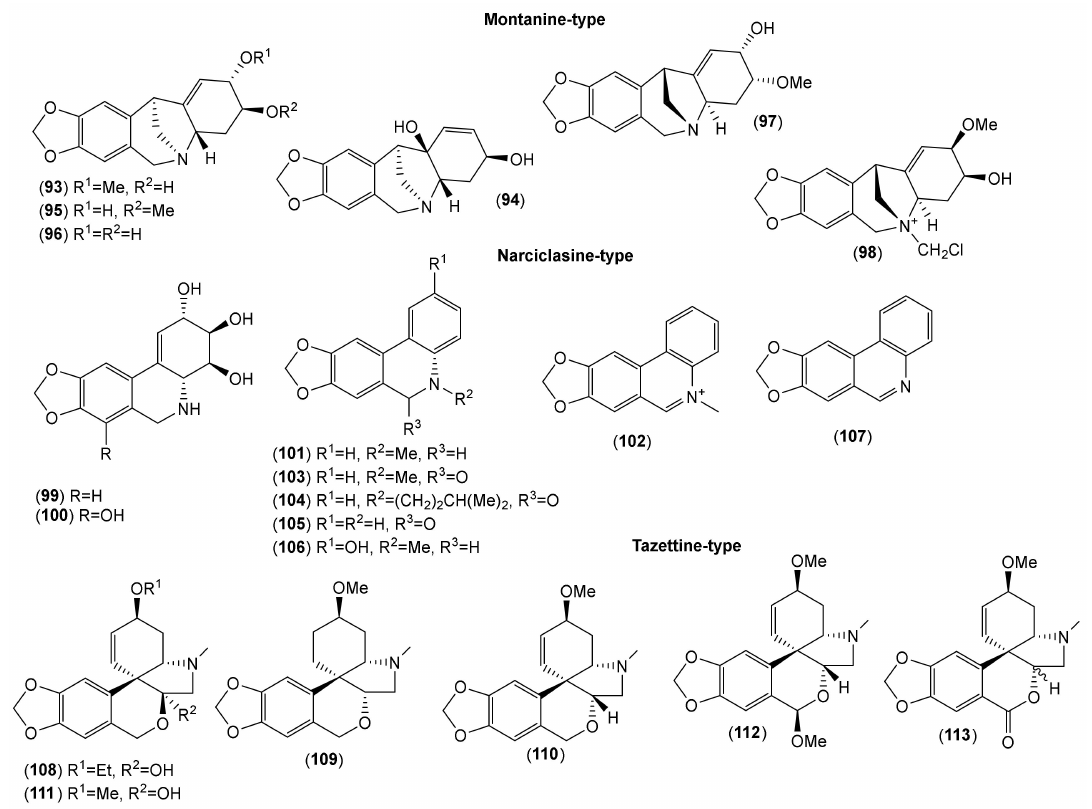
Figure 4. Amaryllidaceae alkaloids of montanine-, narciclasine-, and tazettine-type reported in Lycoris species.